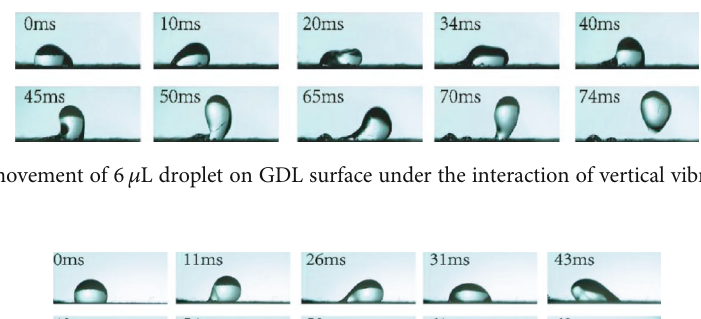
Fig. S1 The photographs of the high-speed camera and light source. Fig. S2: the contact line and contact height of droplet before and after vertical vibration. Fig. S3: the contact line and contact height of droplet before and after horizontal vibration. (Supplementary Materials)